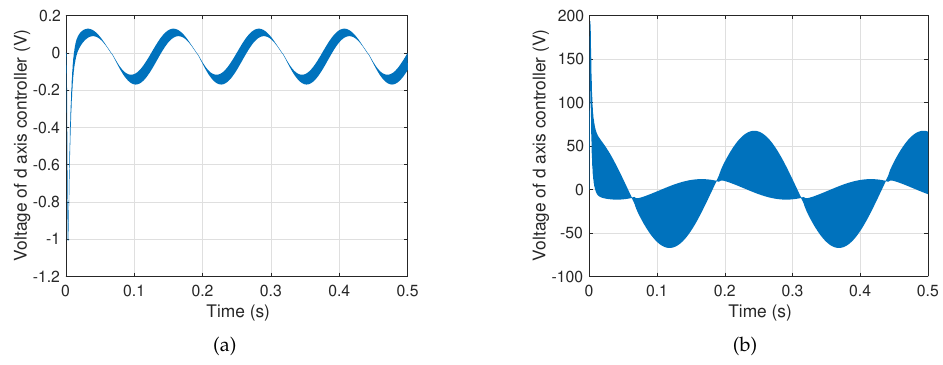
Figure 6. Control input of the proposed controller: ( a ) u d ; ( b ) u q . Based on the fact that the cascaded PI controller and extended state observer-based controller are still widely used in the industry, they served as good candidates to provide benchmarks for assessing the performance of the proposed method. Thus, the cascaded controller in the structure in Figure 7 and state observer-based controller in the structure in Figure 8 were used for performance comparison.